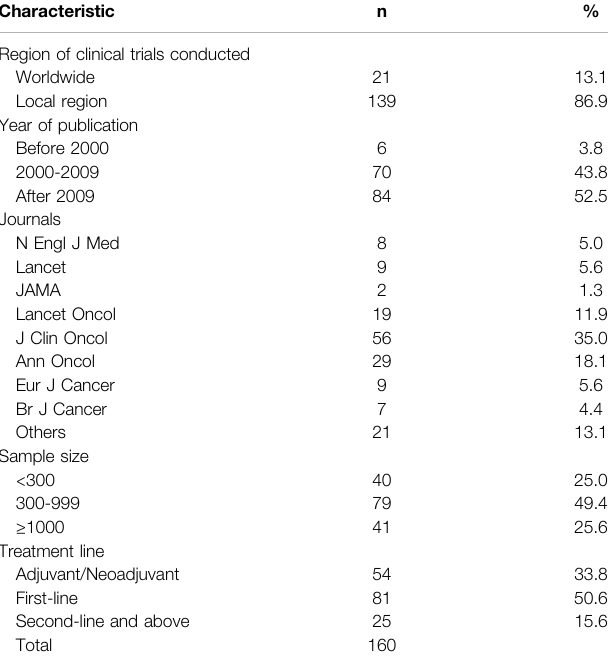
TABLE 1 | Characteristics of enrolled